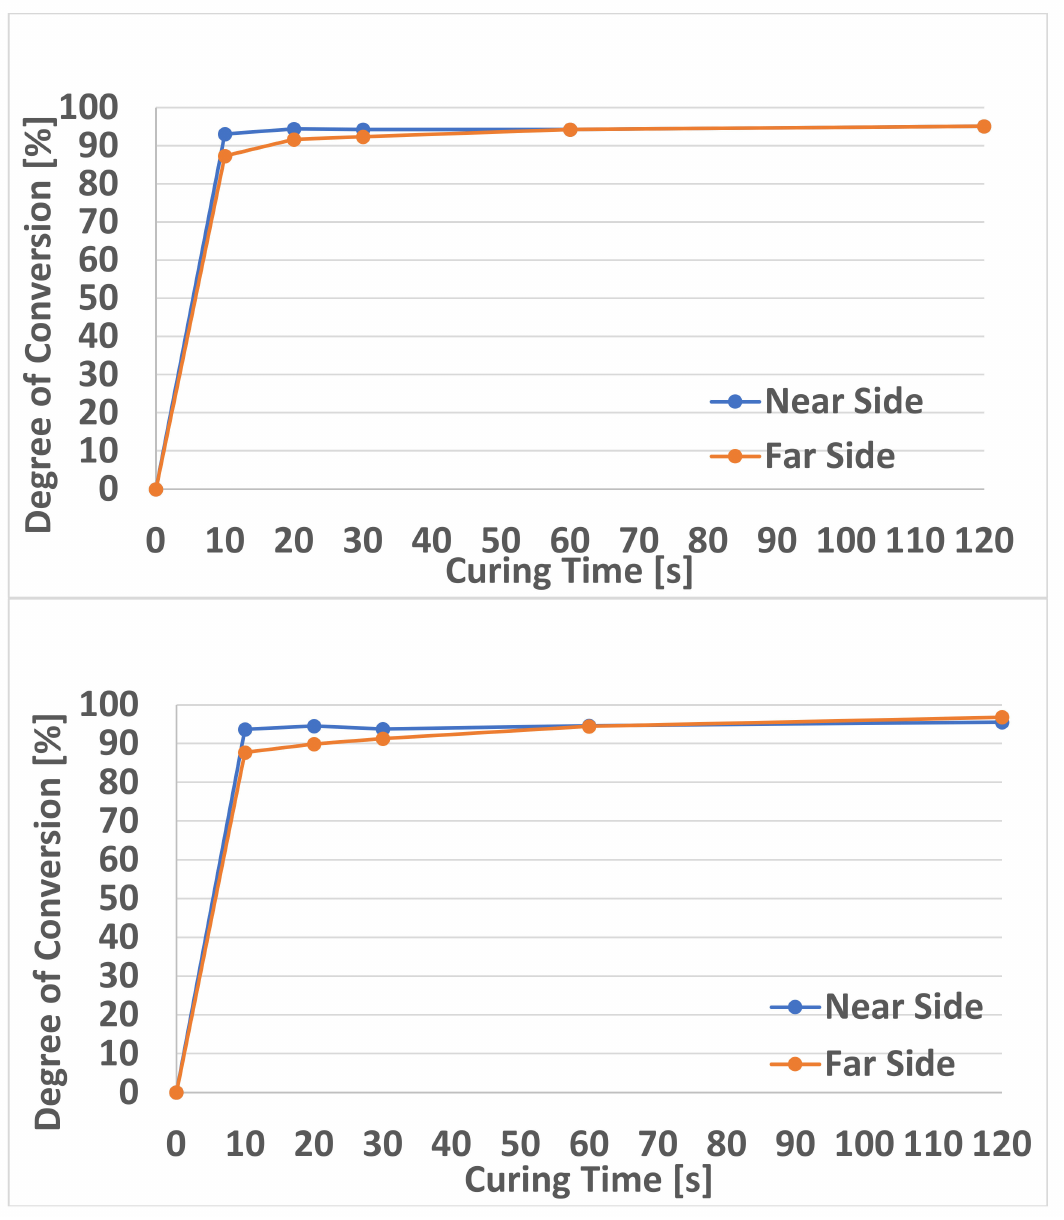
Figure 10. Curing kinetics of the photo-cured PGEnTA containing 0.75 wt.% of WS 2 -C ( top ) and WS 2 -TO ( bottom ) for near side and far